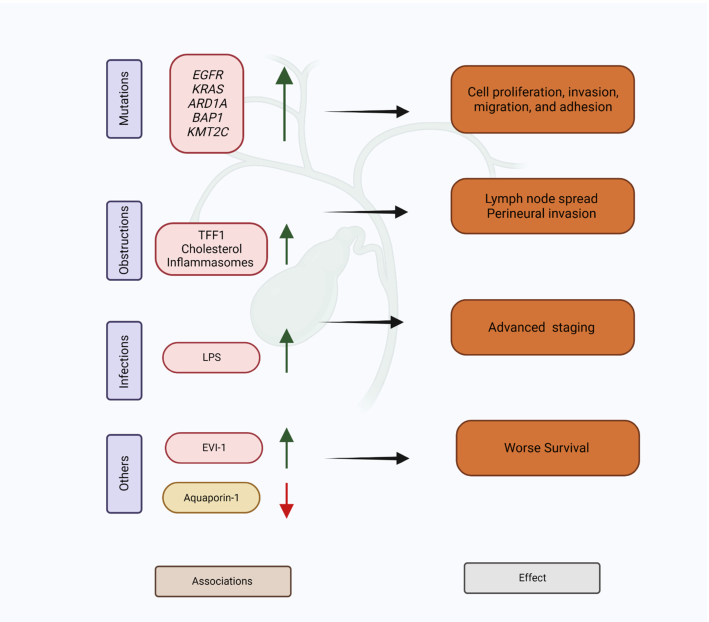
Figure 1. Associations and effects of MUC5AC overexpression in biliary tract cancer. TFF1—Trefoil Factor 1; EVI-1—Ecotropic virus integration site 1 protein homolog;